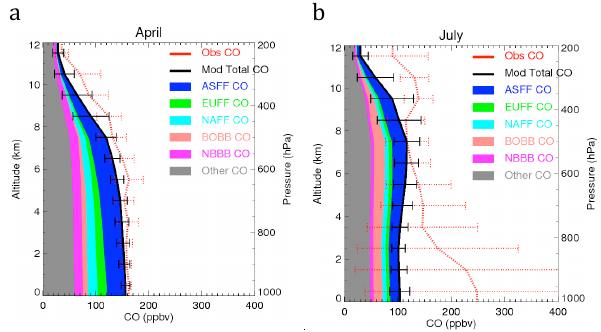
Fig. 8. Vertical distribution of the CO volume mixing ratio (ppbv) from GEOS-5 simulation when the model results are averaged over the Arctic region 50N-90N and 190E-320E for April (a) and July (b) . The GEOS-5 CO is shown by the thick black line for total and by the color shaded areas for the corresponding tagged compo- nents. The “Other CO” refers to the global CO other than the five tagged CO species defined in Fig. 1a and it is mostly attributed to the CO chemical formation from methane oxidation. The CO mix- ing ratio from along the DC-8 flight tracks is also shown by the dotted red line with the standard deviation shown by horizontal bars for a